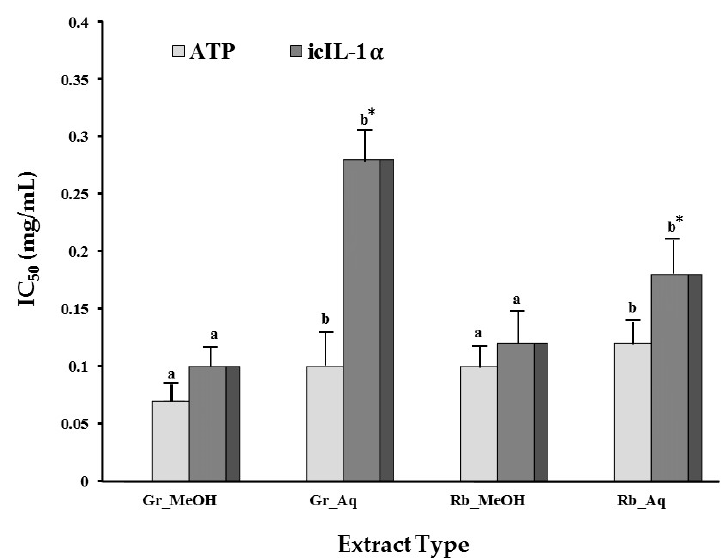
Figure 1. Modulation of cell viability (ATP content) and icIL-1 α accumulation by green tea and rooibos tea in relation to their respective IC 50 concentrations. Values are means of duplicate determinations with five repetitions each. Different letters implies significant ( p < 0.05) differences between the means of the methanol and aqueous extracts within the selected parameter, respectively. Means between * Gr_MeOH and Rb_MeOH (IL-1 α ) and # Gr_MeOH and RB_MeOH (ATP) differ significantly ( p < 0.05). Abbreviations : Gr—green tea; Rb—rooibos; Aq—water; MeOH—methanol.